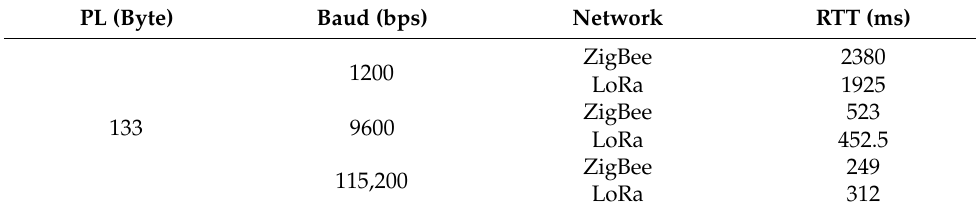
Table 5. The Maximum RTT value in line-of-sight